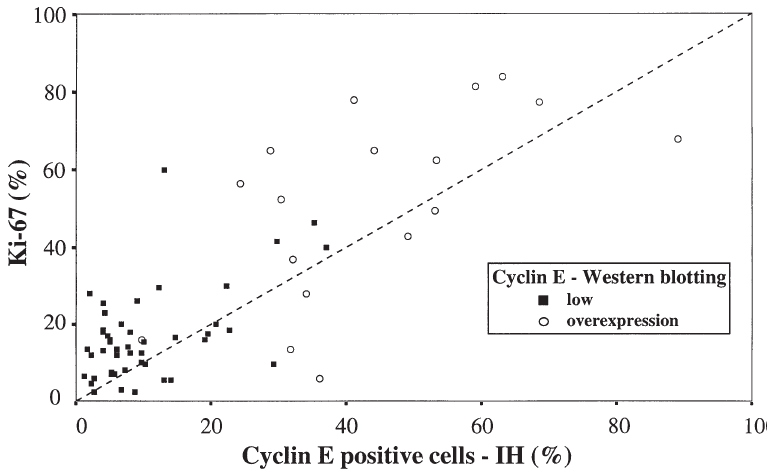
Fig. 3. Scatter plot of the percentage Ki-67 and cyclin E positive cells. Tumours are subdivided into two groups according to the amount of cyclin E determined by Western blotting.